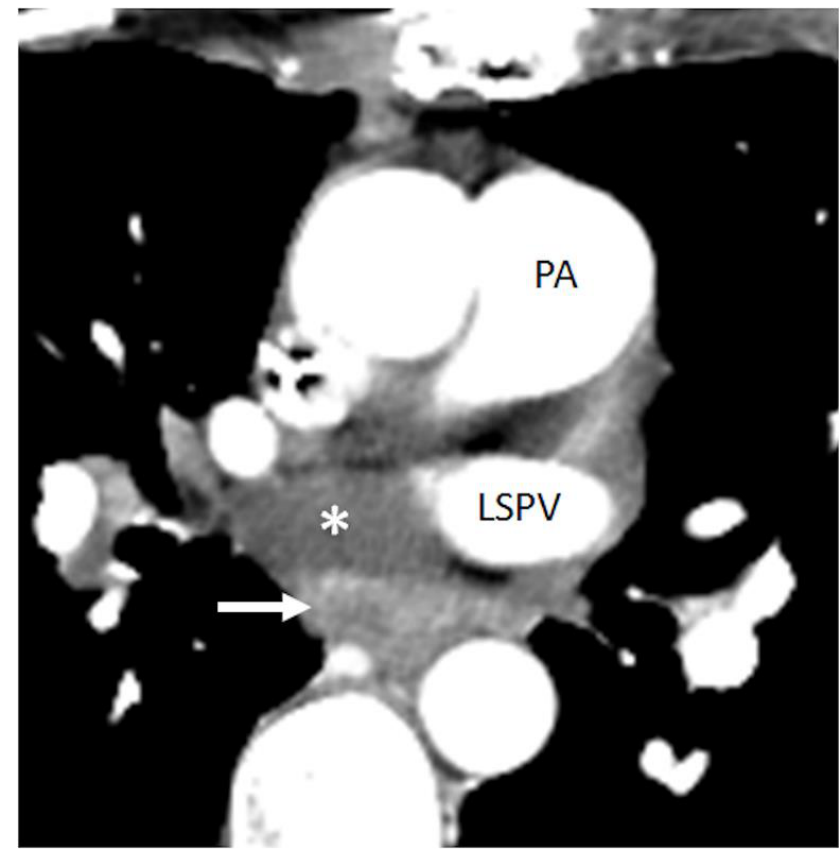
Figure 6. Oblique sinus fluid and adjacent adenopathy. 57 year-old woman with breast cancer. Contrast-enhanced axial CT at the level of the main pulmonary artery shows fluid in the oblique sinus (*) and adenopathy (arrow) posterior to the oblique sinus. Note in this case the difference in attenuation between fluid in the oblique sinus and adjacent enhancing adenopathy. Reprinted from Shroff G.S. et al. Pitfalls in oncologic imaging of the pericardium on CT and PET/CT